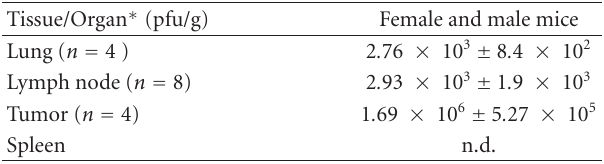
Table 1: Distribution of GLV-1h68 in tissues of PC-3 tumor- bearing nude mice at day 42 after virus